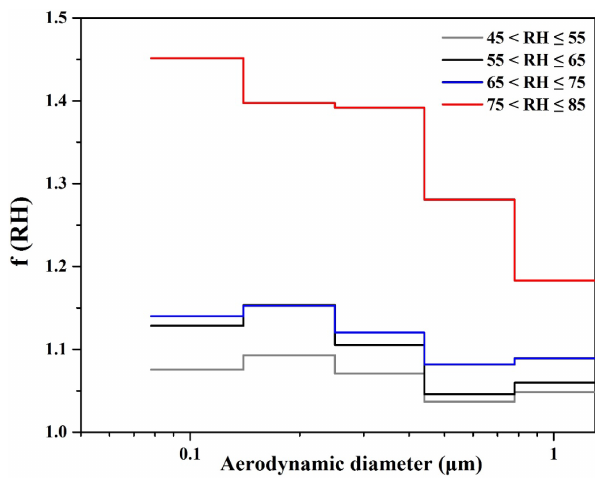
Figure 4. The size distribution of hygroscopic scattering growth of particles under varied relative-humidity levels at the three